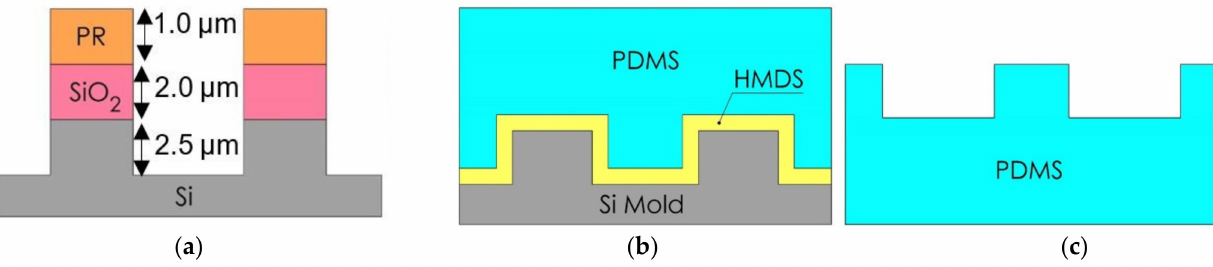
Figure 4. Cross-sectional schematic diagram (not to scale) of ( a ) PR/SiO 2 /Si patterning by conventional photolithography and plasma etching process ( b ) HMDS priming and PDMS casting by soft lithography process, and ( c ) peeled off PDMS sample from the Si master